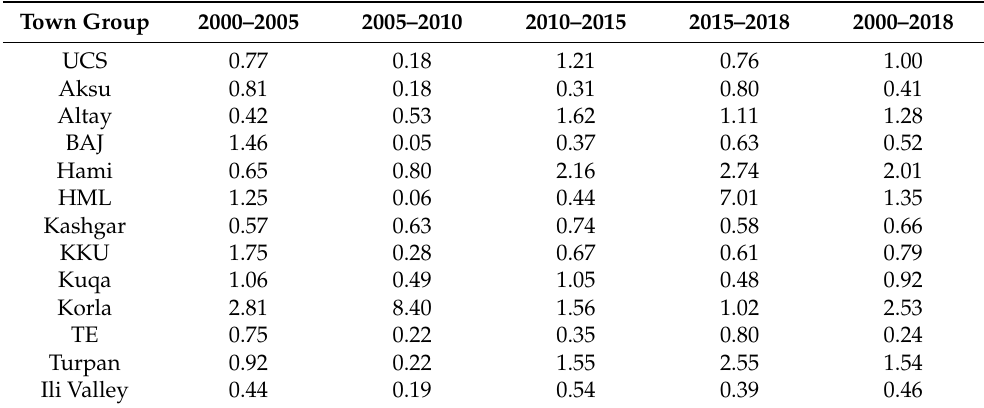
Table 5. The relative variation rate of town groups in five periods unit: (%). Town